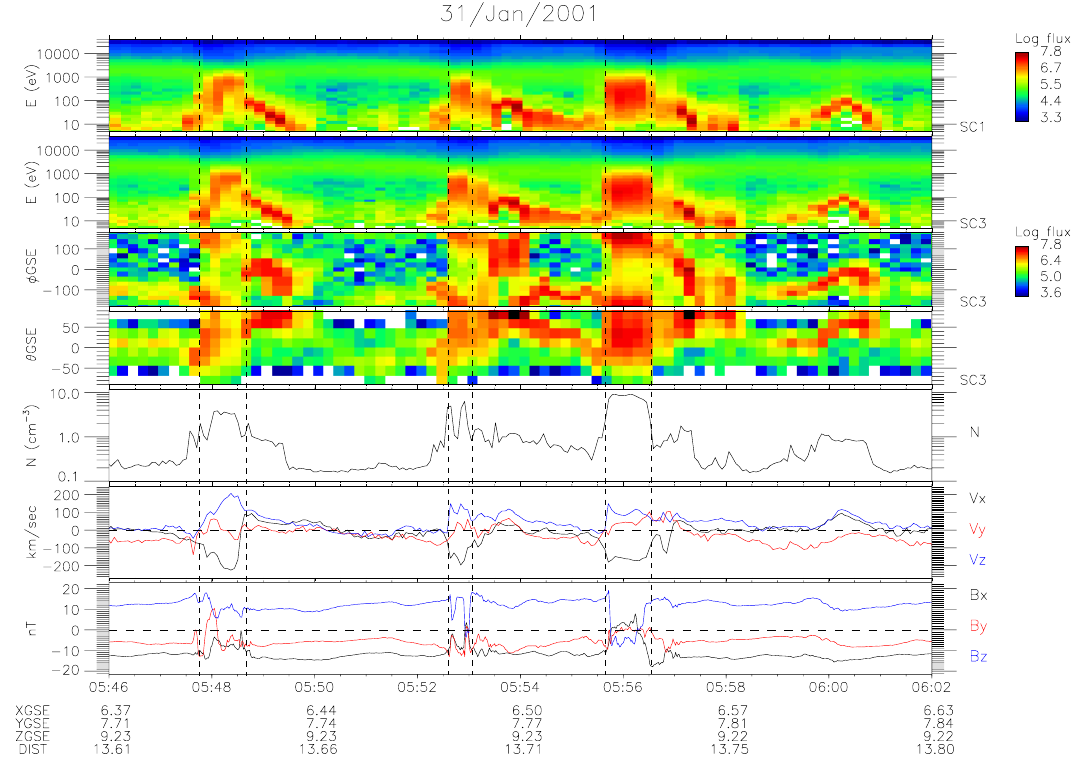
Fig. 3. A close-up of the ion and magnetic field measurements performed between 05:46 and 06:02UT on 10 January 2001 during several encounters with the magnetosheath. The two top panels give the CIS-2 ion energy-time spectrograms for Cluster 1 and 3. The time resolution is 12. The two following panels display the ion anisotropy measured between 5 and 300eV on board Cluster 3 in the spin plane ( φ GSE) and in a rotating plane containing the spin axis ( θ GSE). The fifth and sixth panels give the ion density and the three GSE components of the ion bulk velocity. The last panel displays the three GSE components of the magnetic field